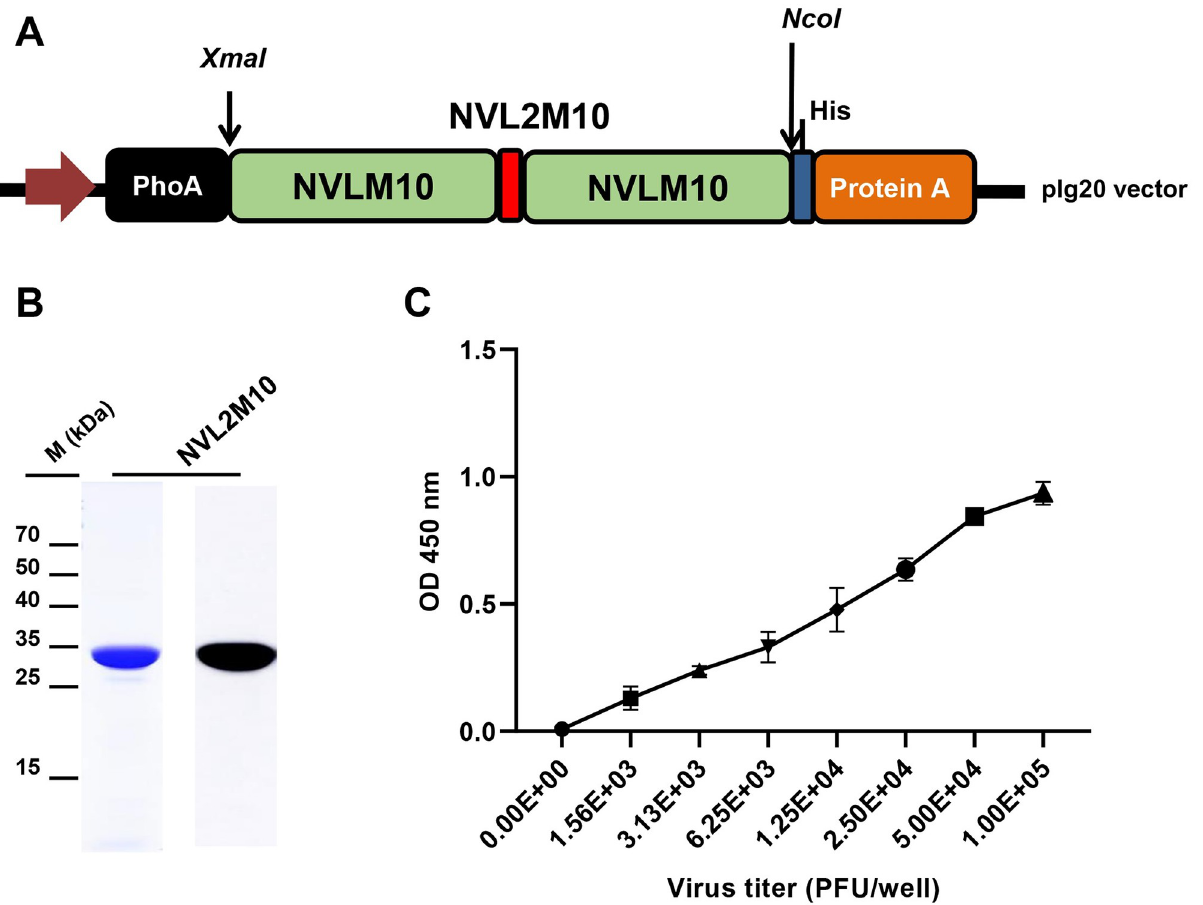
Fig 4. Engineering of a single-domain V L antigen specific to the M2 protein of the H1N1/PR8 virus to a bivalent form. (A) A bivalent single- domain V L specific to M2 (NVL2M10) was constructed by linking two identical single-domain V L s with a linker (G 4 S) 3 and introducing it into the expression vector pIg20. (B) Purification of NVL2M10 (35 kDa) using Sepharose IgG resin exhibited high purity with coomassie blue staining and could detect anti His Abs in western blotting. (C) The binding affinity of NVL2M10 to influenza virions. A total of 250 μ g/mL of NVL2M10 bound to coated influenza virus particles at a 2X serial dilution. The background was subtracted.